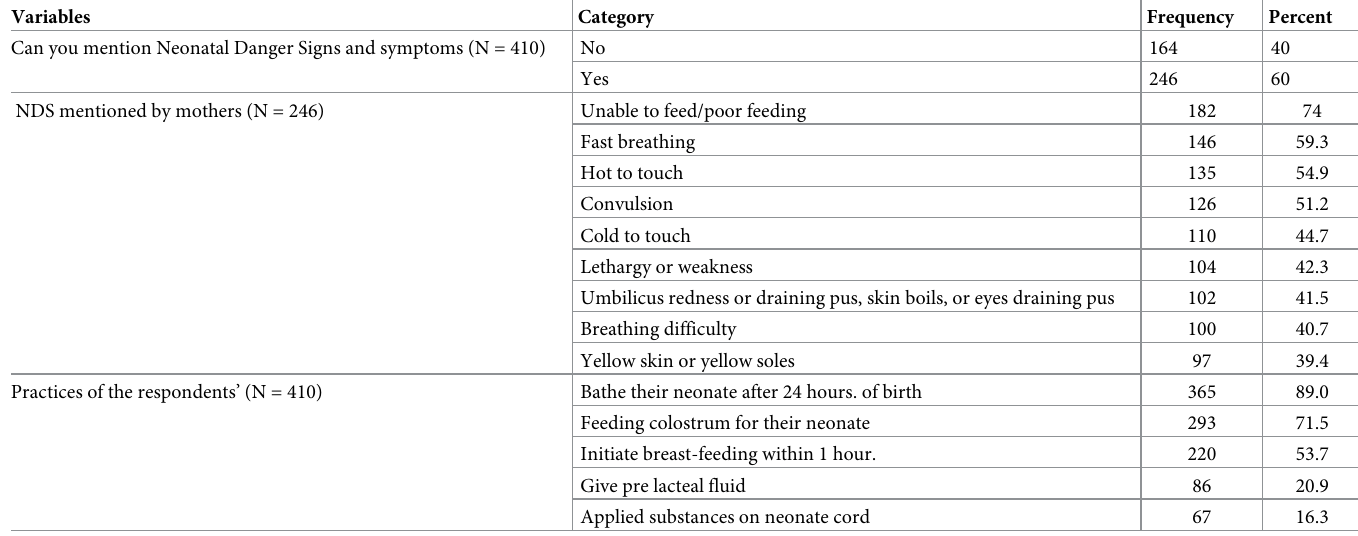
Table 4. Neonatal danger signs mentioned and practices done by postpartum mothers in Shashamane town, Oromia, Ethiopia, 2021. Variables